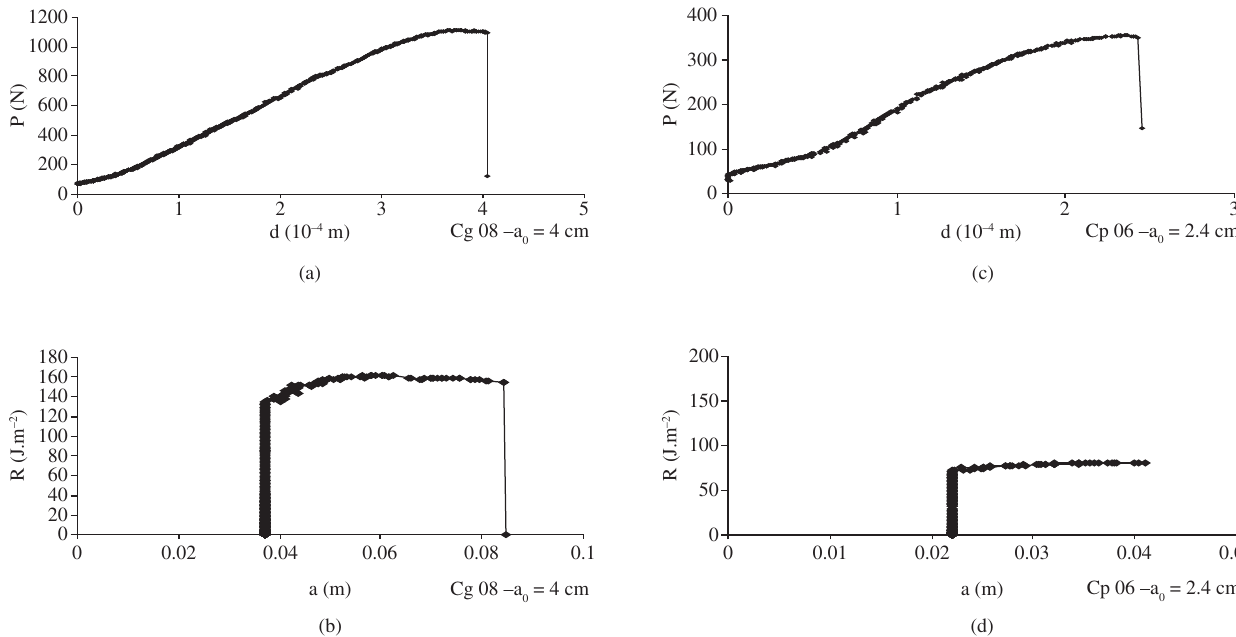
Figure 6. Graphs a-b) correspond to the large test specimens (CP Graphs a, c) are P x d graphs, while b, d) are the corresponding R-curve